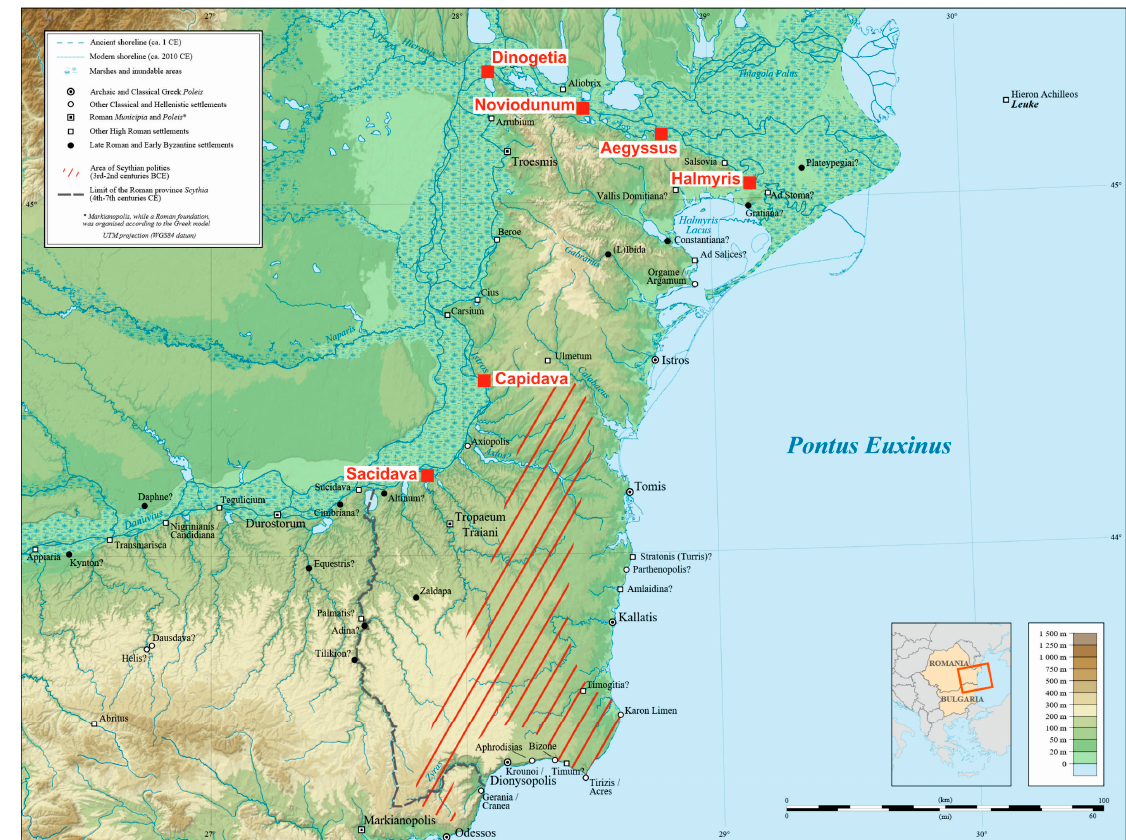
Figure 1. Map of Scythia Minor (source: https://en.wikipedia.org/wiki/Scythia_Minor#/media/ File:Scythia_Minor_map-en.svg (accessed on 7 August 2022); red squares represent the